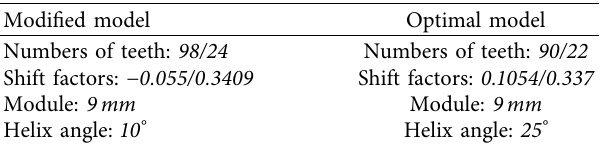
Table 10: Parameter comparisons between optimal and modified helical